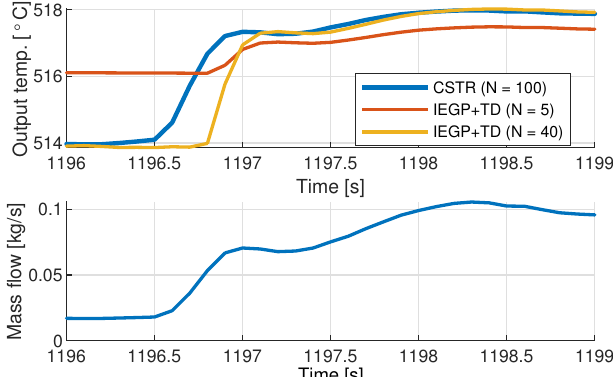
Figure 7. Output temperature for different models during a rapid change in mass flow. When looking at the output concentrations in Figure 6, larger differences can be seen. For N = 1 the results are very similar, but for 1 < N ≤ 40 the time-delayed IEGP model shows significantly better results. However, without the time delay the IEGP model does not show good results. This is because small time delays can bear a huge effect on the instantaneous error in transients. This can be seen in Figure 8 where the IEGP model with and without time delay is compared to the CSTR model. As can be seen, with the time delay the IEGP model produces almost identical output as the CSTR model, but without the time delay it is a fraction of a second before thus resulting in large instantaneous differences.